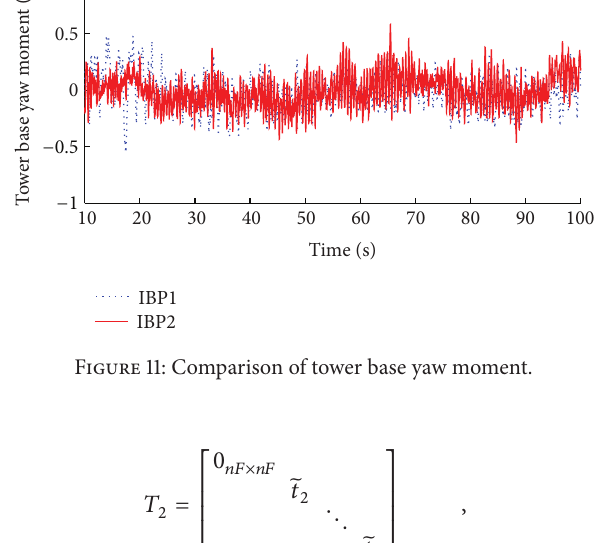
Figure 10: Comparison of blade flapwise moment.